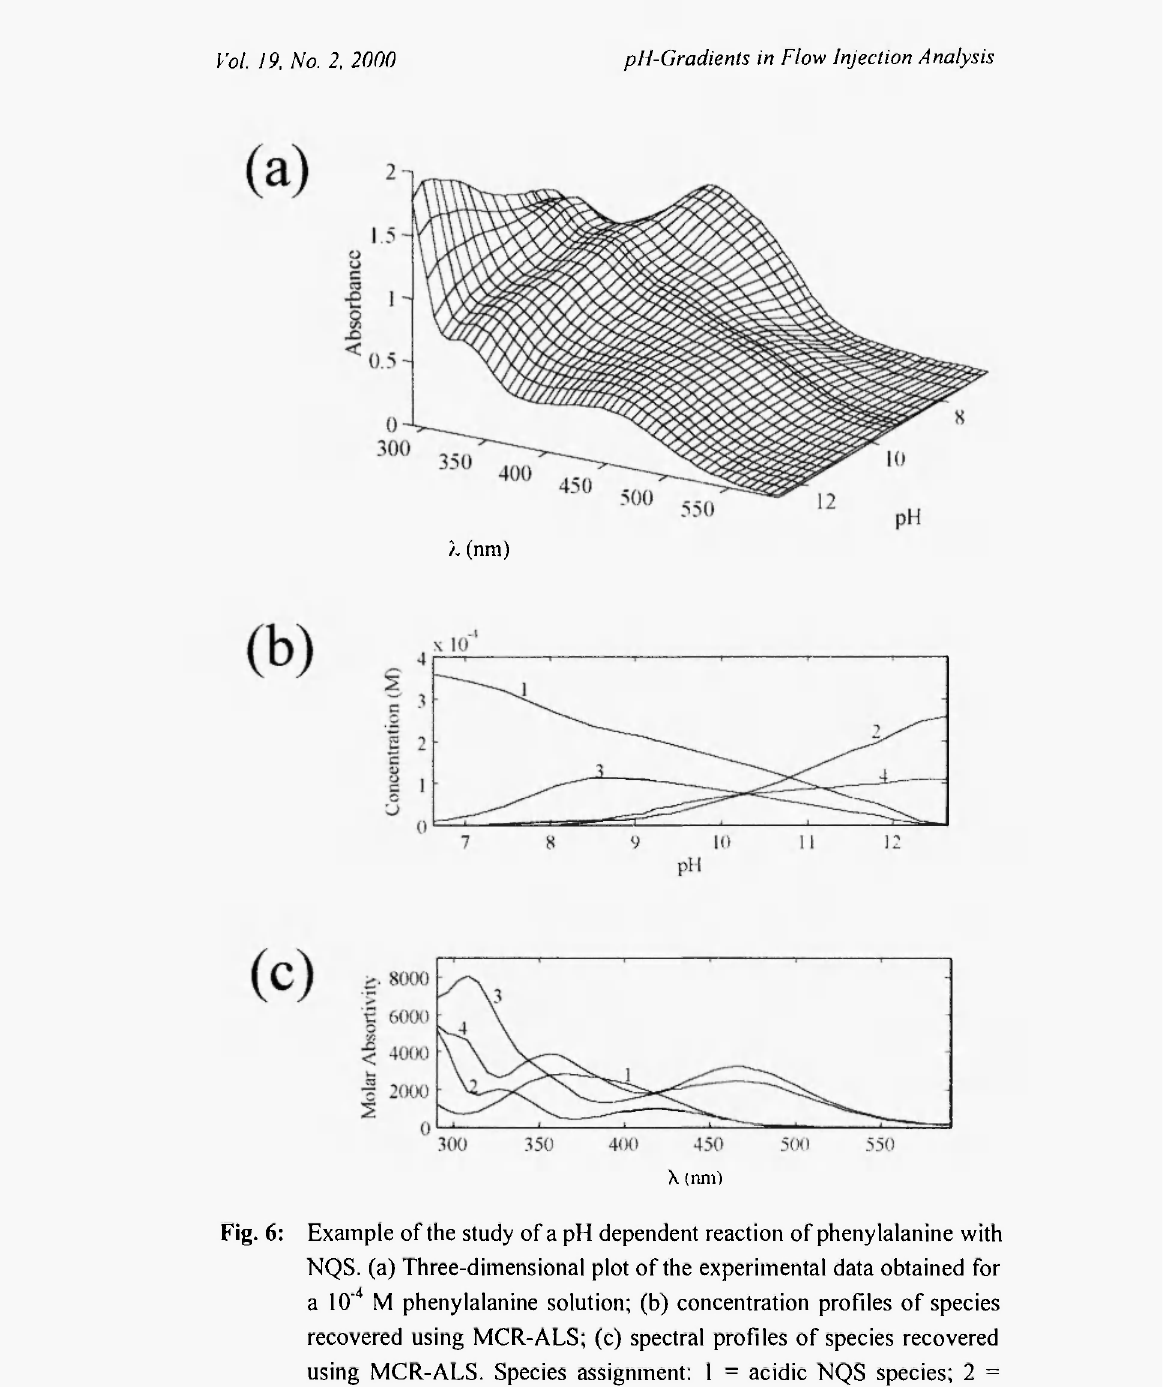
Fig. 6: Example of the study of a pH dependent reaction of phenylalanine with NQS. (a) Three-dimensional plot of the experimental data obtained for a 10~ 4 Μ phenylalanine solution; (b) concentration profiles of species recovered using MCR-ALS; (c) spectral profiles of species recovered using MCR-ALS. Species assignment: 1 = acidic NQS species; 2 = Basic NQS species; 3 = acidic derivative species; 4 = basic derivative